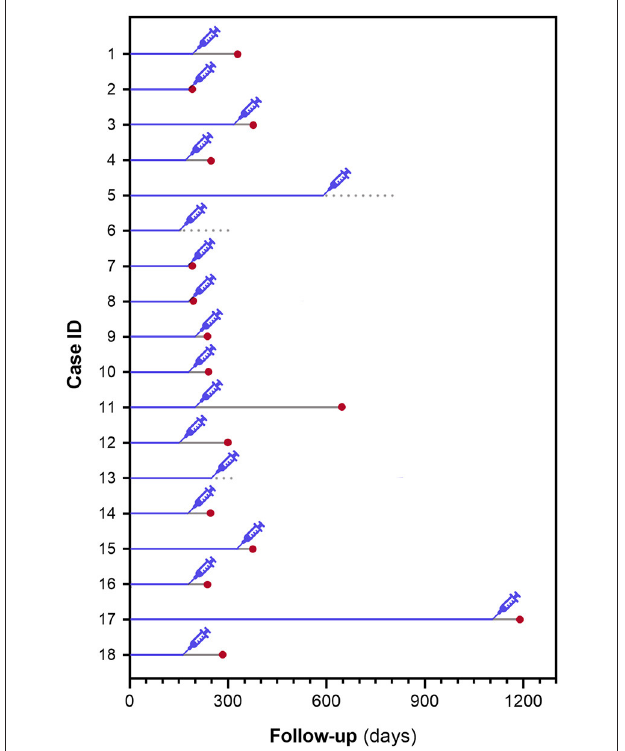
FIGURE 1 | Schematical representation of time from DLBCL diagnosis to anesthesia and time from anesthesia to lymphoma relapse in 18 dogs undergoing an anesthetic